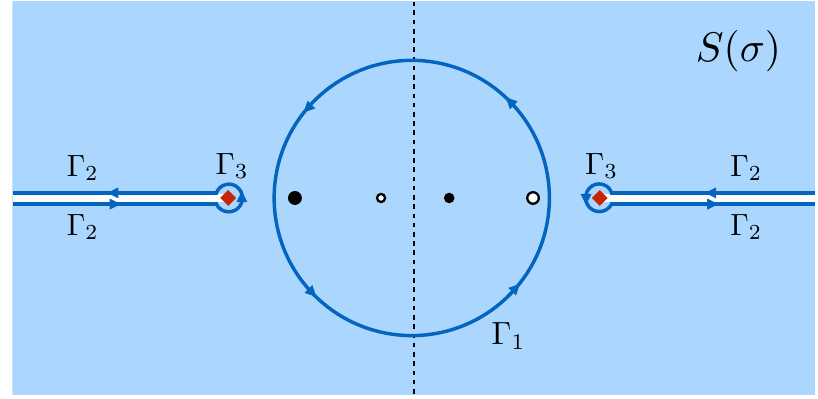
Figure 12 . Contour integrals describing the contributions of various states to the crossing equation (6.19) at the leading order as (cid:1) . (cid:0) 1 , (cid:0) 2 and (cid:0) 3 give the contribution of ! 1 bound states, two-particle states and (cid:22) = 2 states respectively. The integrand takes the form ( (cid:27) 2) (cid:27) (cid:0) 3 = 2 (4 (cid:27) ) (cid:0) 3 = 2 [ S ( (cid:27) ) + 1]. Conformal bootstrap at the leading order in 1 = (cid:1) is equivalent (cid:0) (cid:0) to the total contour integral being zero, in other words to the analyticity of the S-matrix away from the real